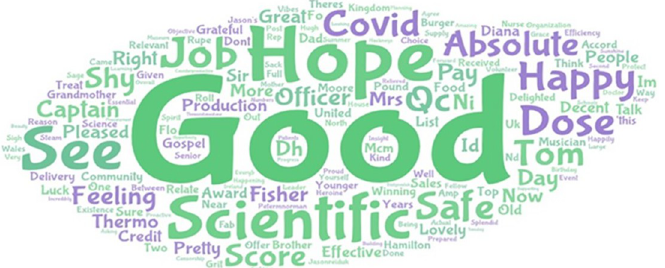
Fig 2. Word cloud based on positive sentiment for vaccine-related tweets, Great Britain. Source: Authors own compilation using word cloud software.